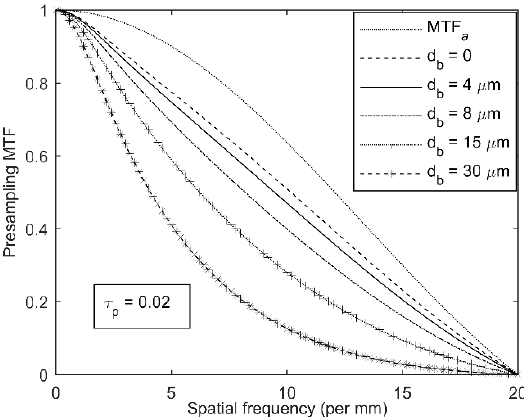
Figure 4. The MTF( f ) as a function of the blocking layer thickness for a-Se mammographic detectors.